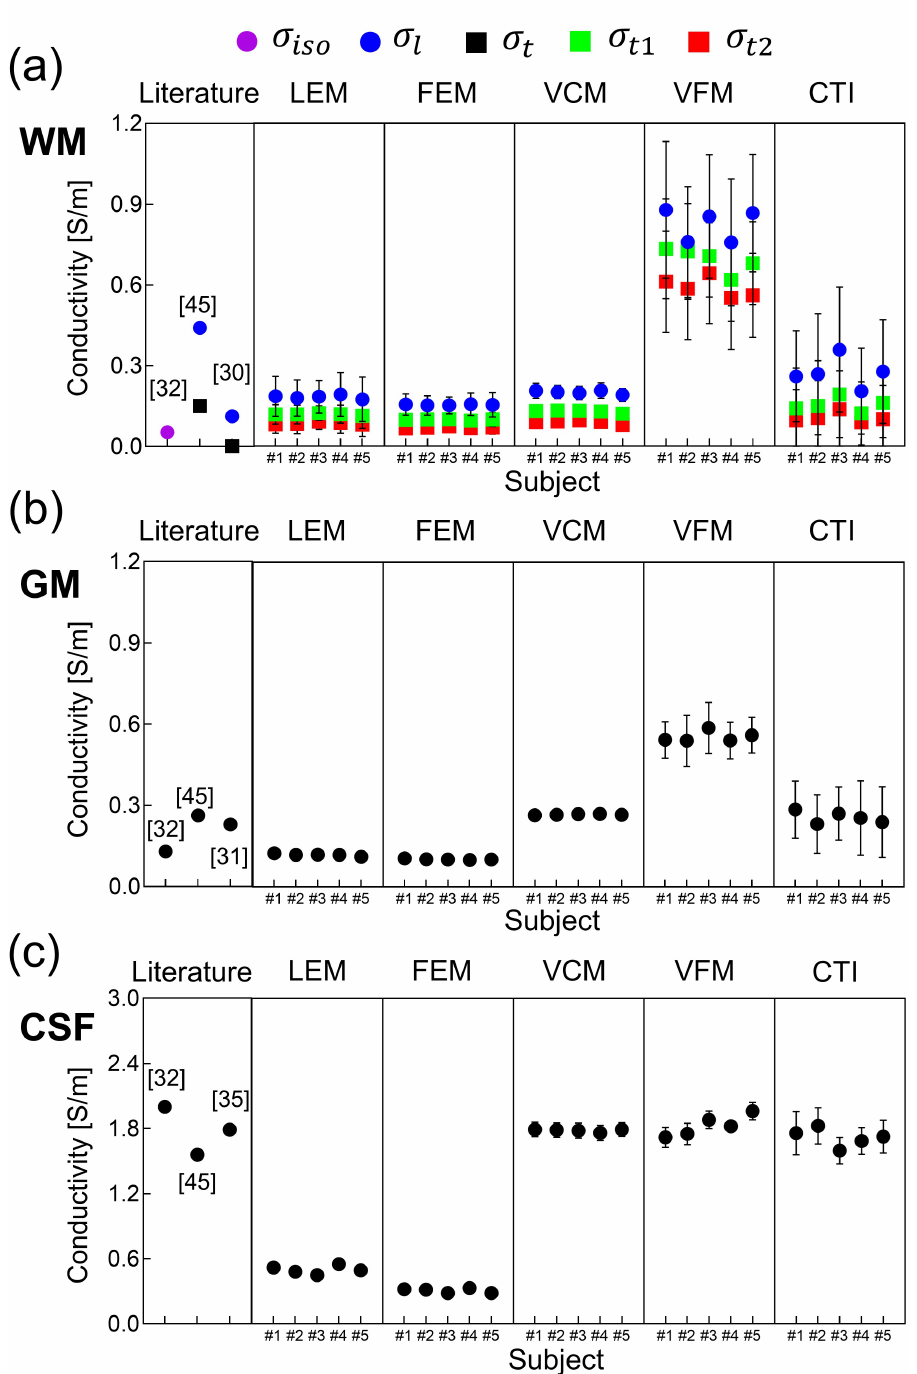
Figure 4. Mean and SD values of the reconstructed conductivity tensors using the five methods for all five human subjects are compared with the existing literature values. ( a ) are conductivity values from WM region, ( b , c ) are from GM and CSF, respectively. For the WM region, the mean and SD values of σ l , σ t 1 , and σ t 2 are plotted. For the GM and CSF regions, the mean and SD values of σ L = σ l + σ t 1 + σ t 2 are plotted. The vertical bar represents the 3